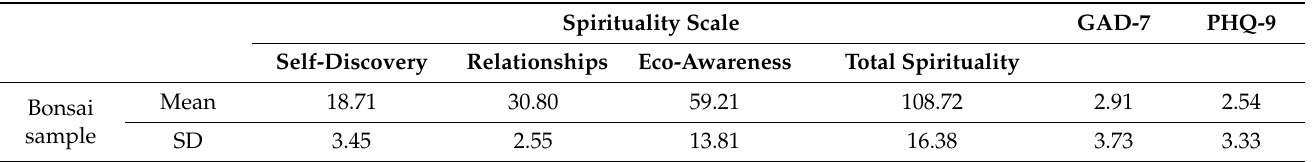
Table 2 refers to the scores on the Self-Discovery, Relationship and Eco-Awareness sub scales of the Spirituality Scale fall within the upper limits of all subscales and therefore indicate high spirituality. Scores of 5, 10, and 15 are taken as the cut-off points on the GAD-7 for mild, moderate and severe anxiety, respectively. The participants’ scores had a mean of 2.91 and a standard deviation of 3.73, indicating an overall low score for anxiety. The PHQ-9 has similar scores, and 5, 10, 15 and 20 are taken as the cut-off points on the GAD-7 for mild, moderate moderately severe and severe depression, respectively. The participants’ scores had a mean of 2.54 and a standard deviation of 3.33, indicating a low score for depression. Table 2. Includes a summary of the means and Standard Deviation (SD) of the bonsai sample.